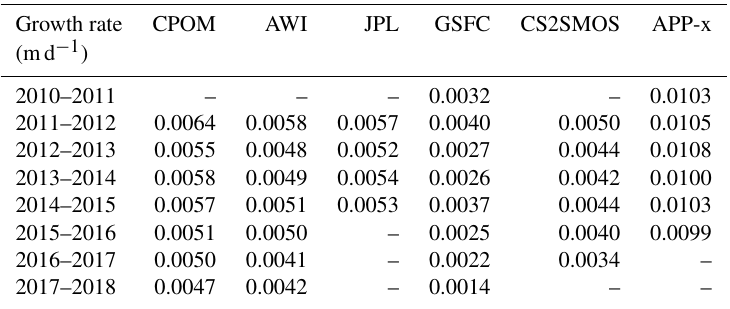
Table 5. Winter (October–April) sea ice thickness growth rate (md − 1 ) for the period 2010–2018 in the central Arctic (regions 1–6), where rates are calculated based on product availability during each growth season. Growth rate CPOM